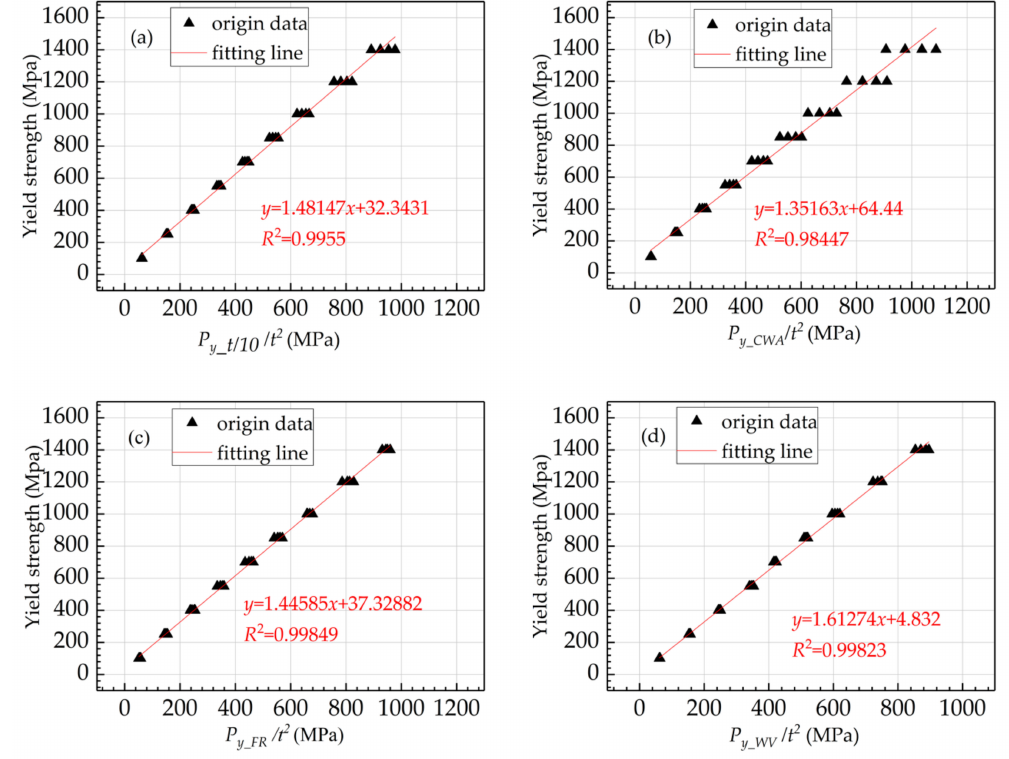
Figure 12. Linear fit results of yield load: ( a ) t / 10 method; ( b ) CWA method; ( c ) FR method; ( d ) WV